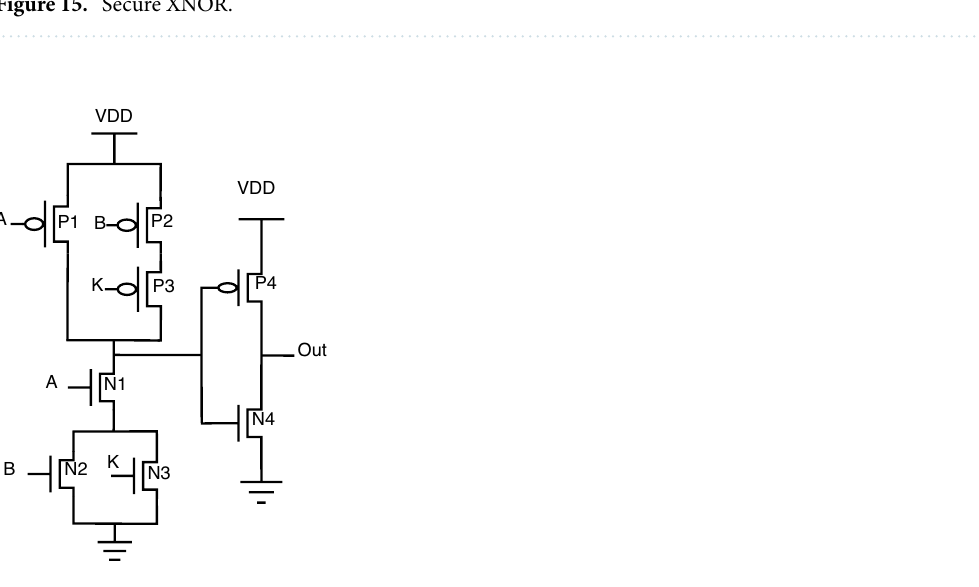
Figure 15. Secure XNOR.